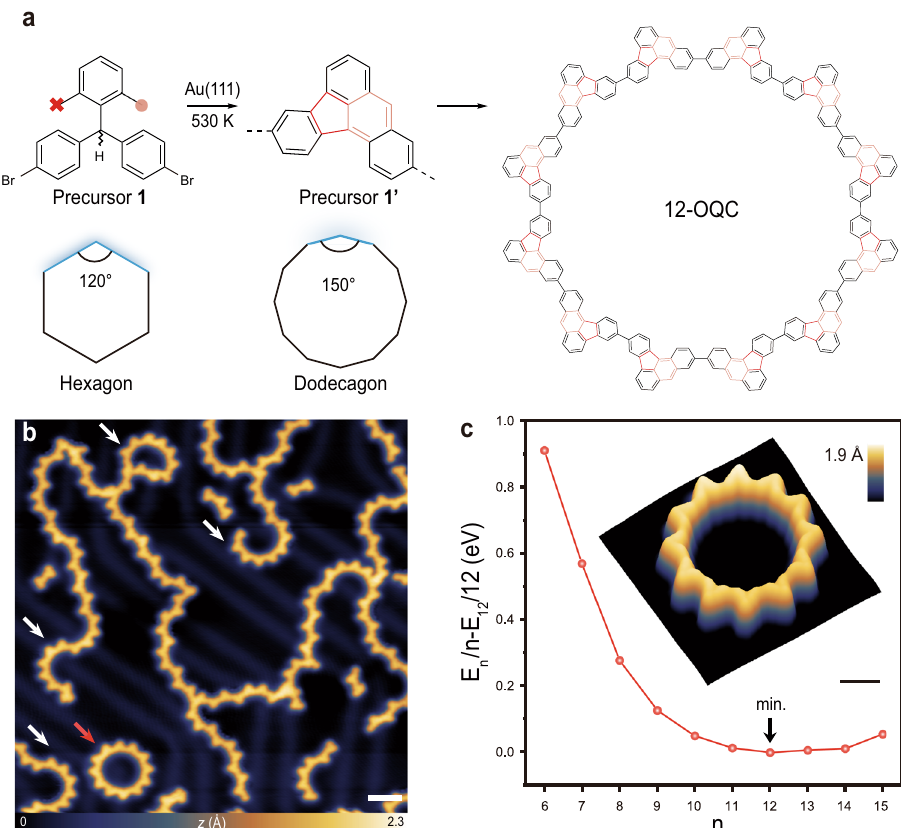
Fig. 1 On-surface synthesis of covalently linked macrocycles. a Schematic illustrating the synthetic pathway from precursor (left) to the 12-unit macrocycle (right) with a proposed intermediate (precursor 1 ′ ) with embedded pentagonal ring (middle). The as-formed benzenoid rings (dehydrogenative cyclization) and pentagonal rings (demethylation) are highlighted in orange and red, respectively. Hexagon and dodecagon illustrate the corresponding geometries of polymer rings synthesized from precursor 1 and precursor 1 ′ (internal angle between the coupling sites is highlighted in blue). b Overview STM image after annealing precursor 1 on Au(111) at 530 K, revealing individual 12-unit macrocycle (one of them is highlighted with a red arrow) coexisting with curved segments or half rings (highlighted with white arrows) and polymer chains ( V = 1.0 V, I = 200 pA). c Plot of energy differences between total energy divided by number of units and the reference energy of 12-unit macrocycle (zoom-in plot of the region around the energy minimum ( n = 12) is shown in Supplementary Fig. 4). Inset shows the three-dimensional STM image of one 12-unit macrocycle ( V = − 0.1 V, I = 200 pA). The scale bars in ( b ) and ( c ) are 3 and 1 nm,